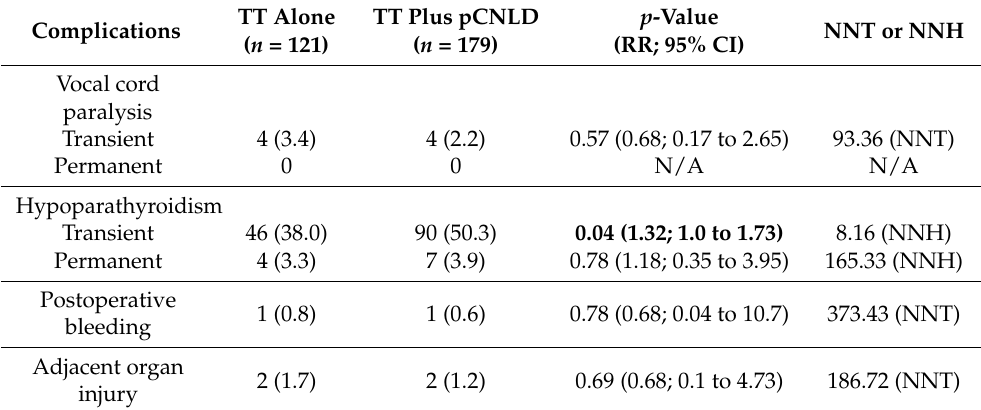
Table 3. Complications grouped by the primary predictor variable.